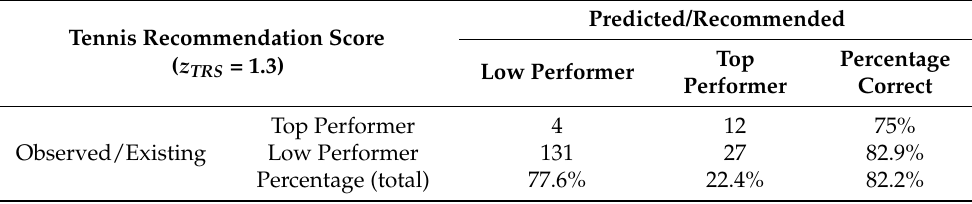
Table 4. Sensitivity and specificity of the tennis recommendation score at z TRS = 1.3.